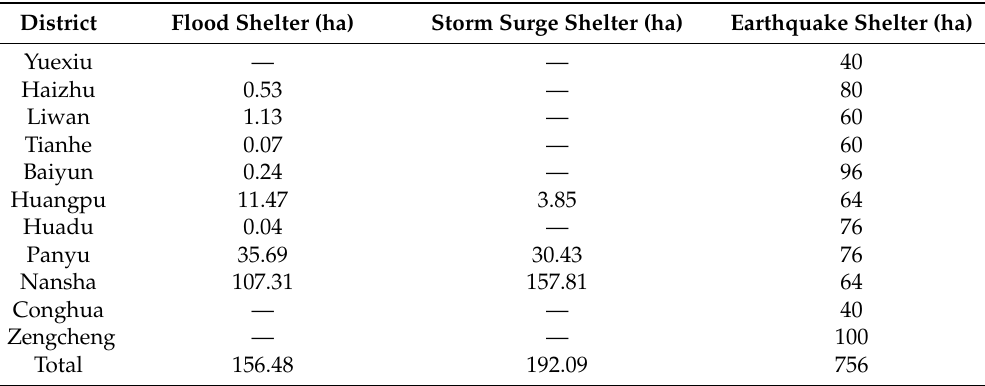
Table 6. Shelter demand prediction in multi-hazard environment.